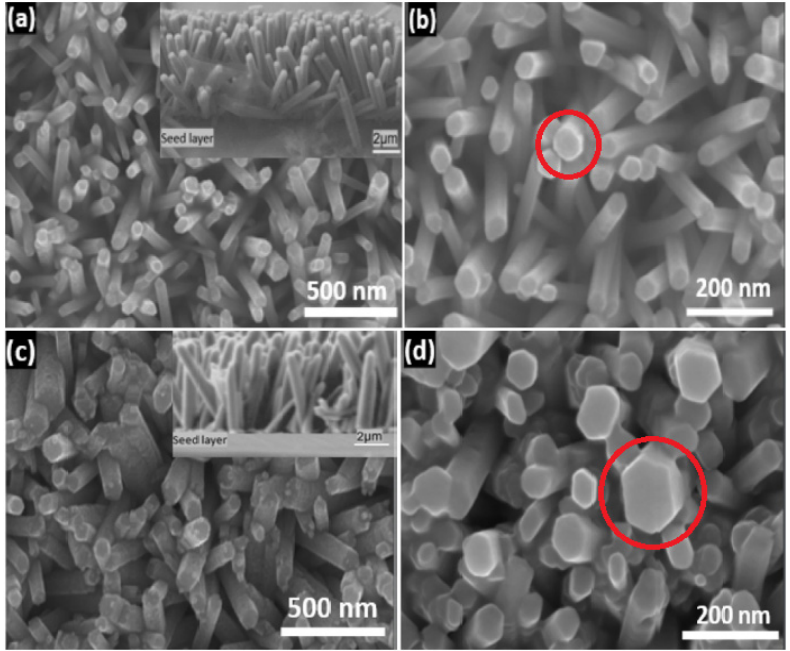
Figure 4. ( a – d ) High and low magnification FE-SEM images of ZnO NRs growth on silicon and glass substrates. The insets at the upper right-hand corner in ( a – c ) show the cross-sections. Sketch red circles in ( b , d ) show a hexagonal polar face in [0001] direction. Reprinted with permission from ref. [89]. Copyright 2021 Elsevier.